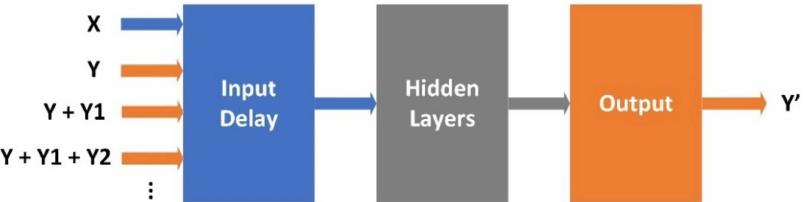
Figure 13. System configuration used to expand the size of the training dataset by adding random noise (X—input data; Y—measured data; Y’—predicted data; Y+Y1—added noise in the 1st iteration step; Y + Y1 + Y2—added noise in the 2nd iteration step).